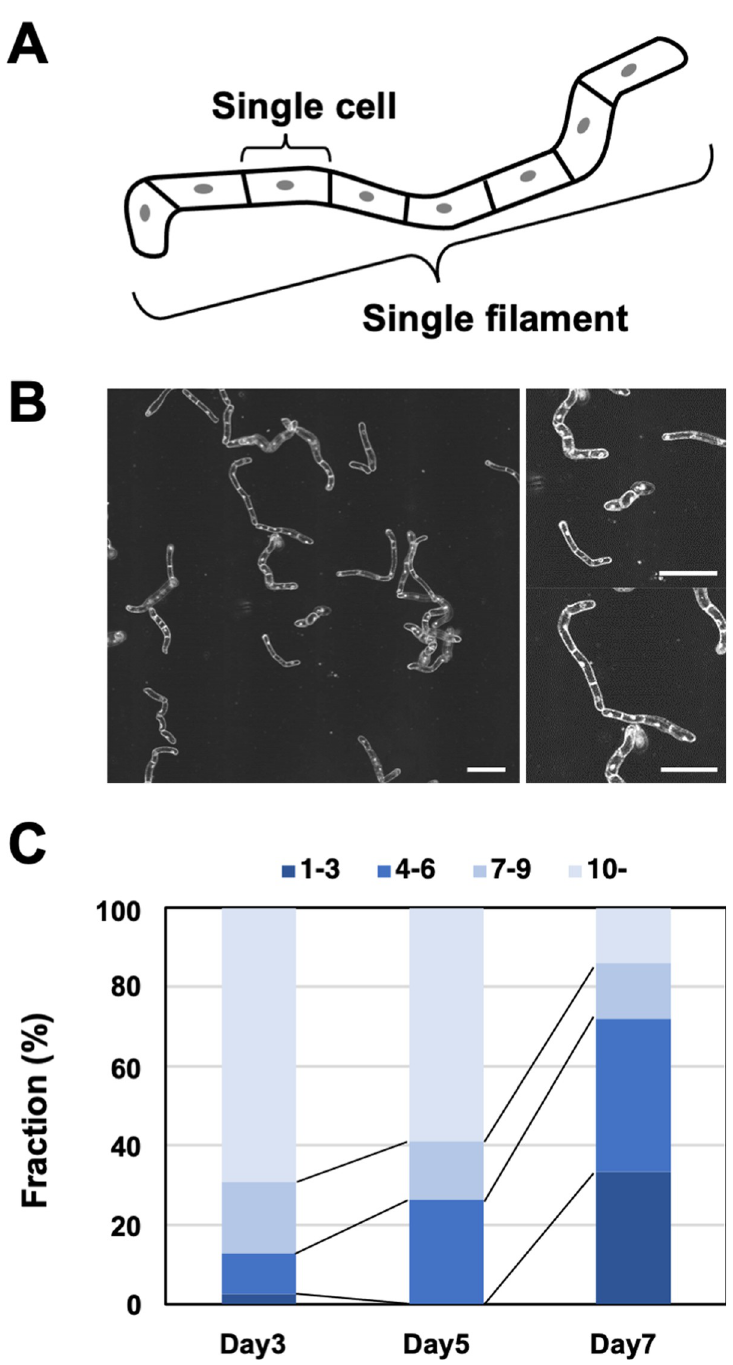
Fig 1. Properties and shapes of BY-2 cells. (A) Schematic image of a BY-2 cell. (B) Representative images of BY-2 cells under phase-contrast microscope. Scale bars, 200 μ m. (C) Distribution of number of cells in a single filament of BY-2 cells on days 3, 5, and 7 of culture. Total number of filaments counted at day 3, 5 and 7 were 39, 34 and 57, respectively.